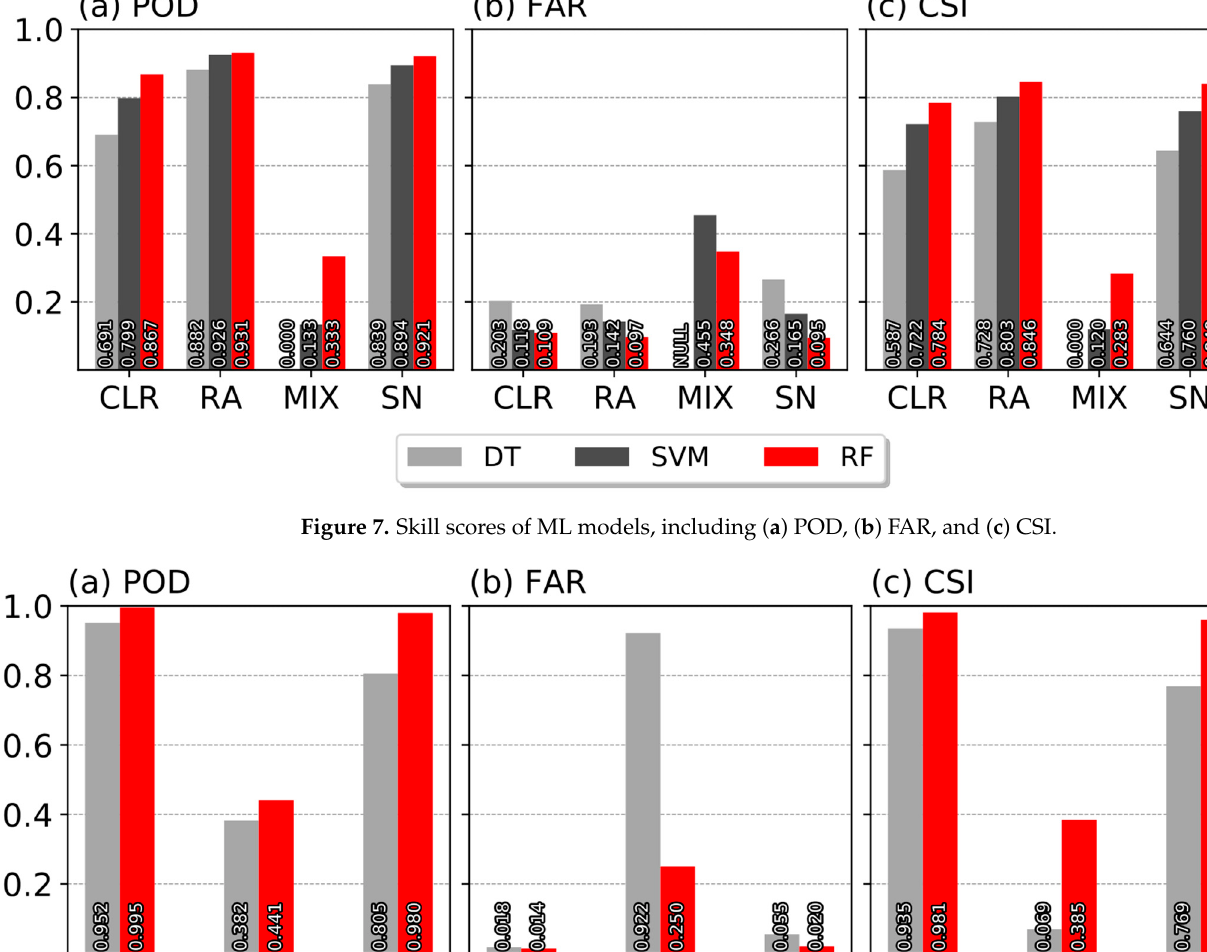
Figure 9. Examples of RF classification in ( a ) rain-dominant case (0310 LST, 1 March 2022) and ( b ) snow-dominant (1420 LST, 15 February 2022). The circle filled with color indicates the ground truth. The insets in ( a , b ) are zoom-in-boxes, providing a clear view of the classification.